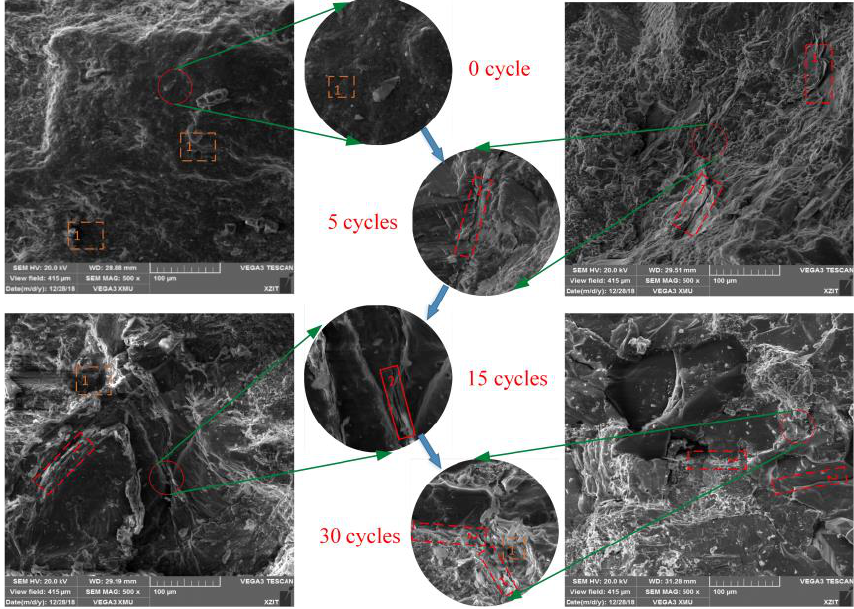
Figure 7. SEM micrographs of sandstone samples under F-T actions. Orange frame 1: pore; Red frame 1: intergranular fracture; Red frame 2: transgranular fracture.